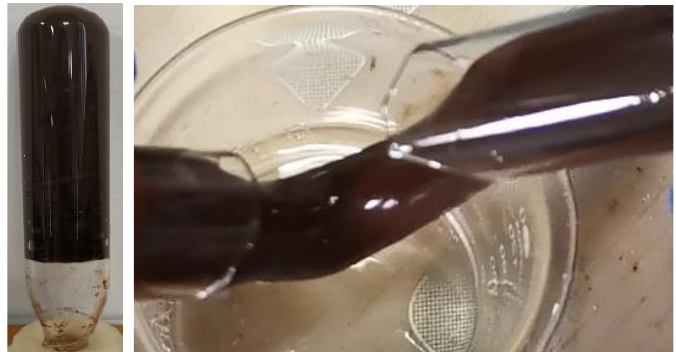
Figure 4. Morphology of Post-gelatinizing Naphthol Gel.